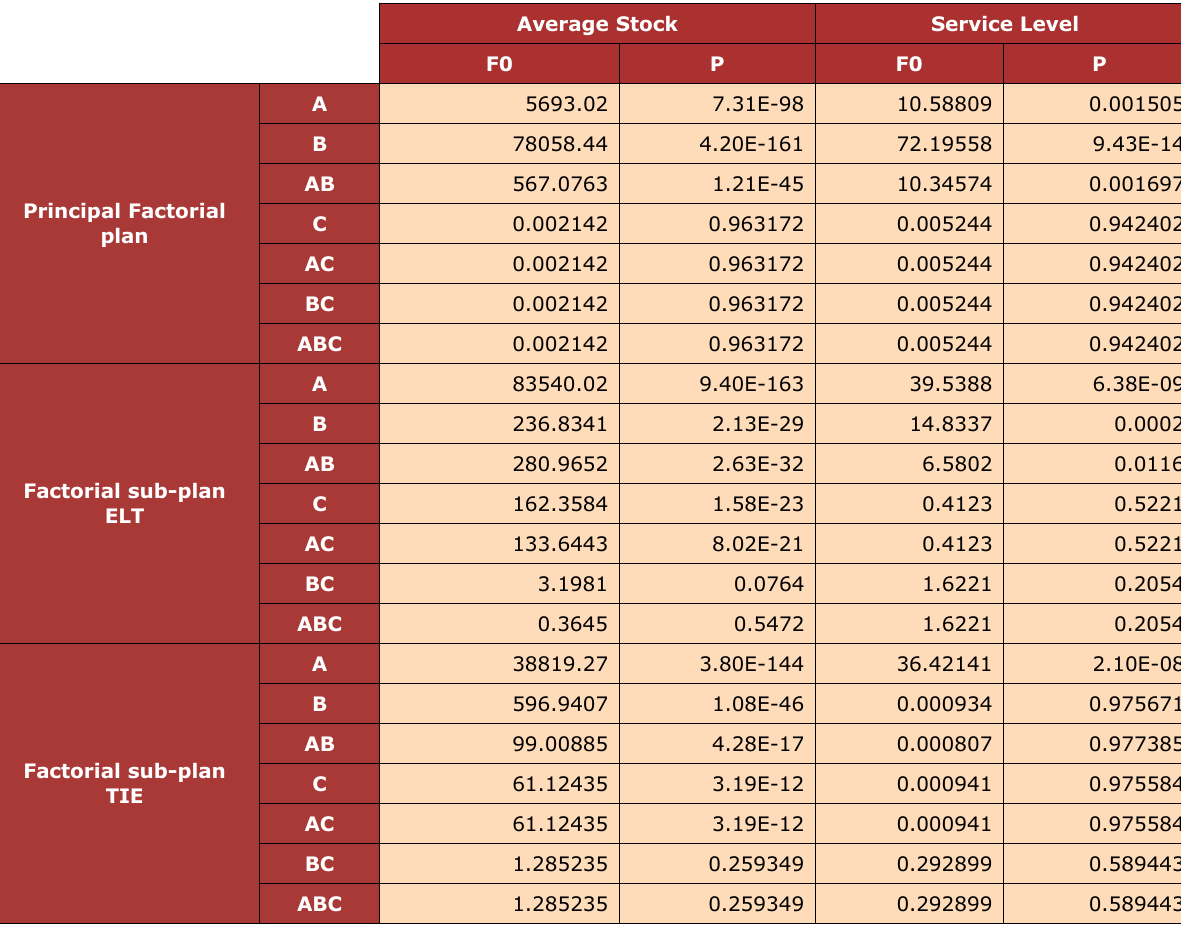
Table 2. Results of the DoE analysis